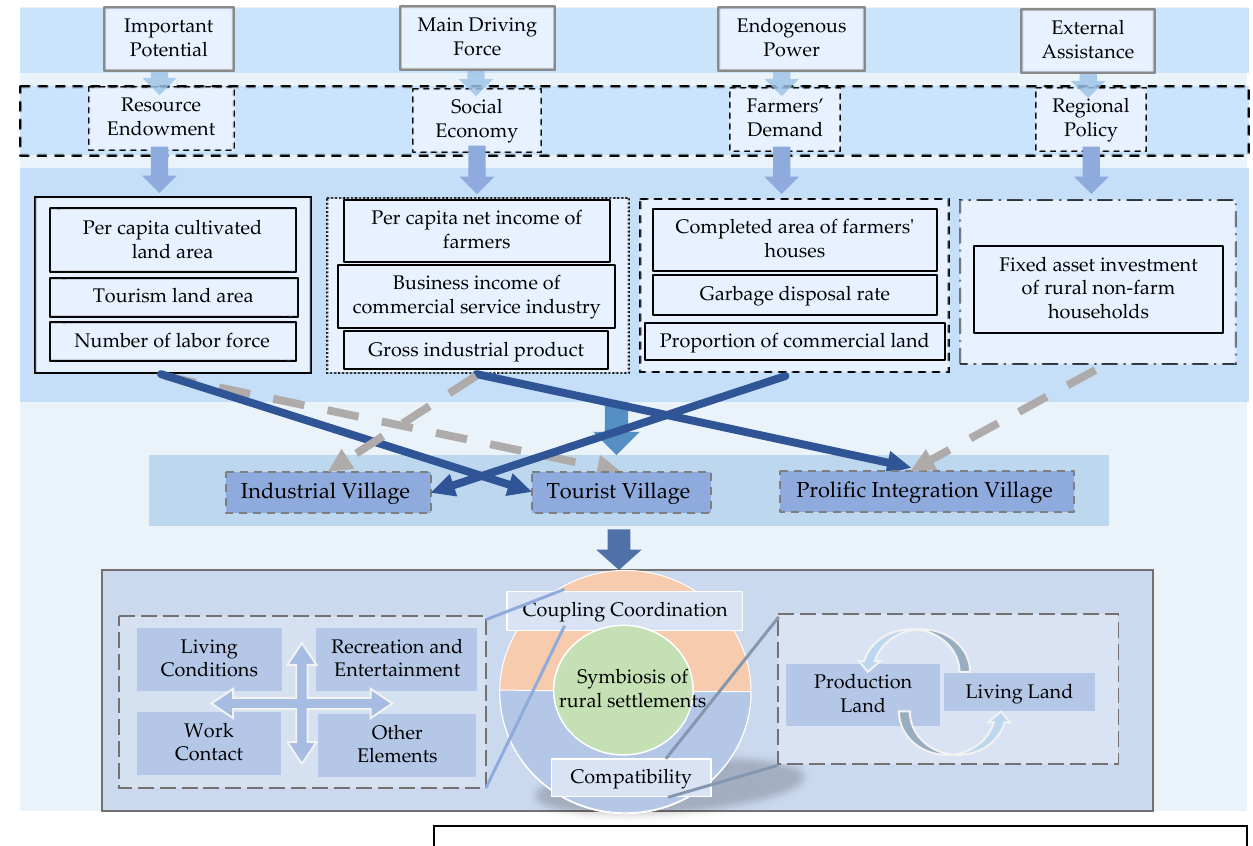
Figure 7. Driving mechanism of symbiosis between production land and living land in rural